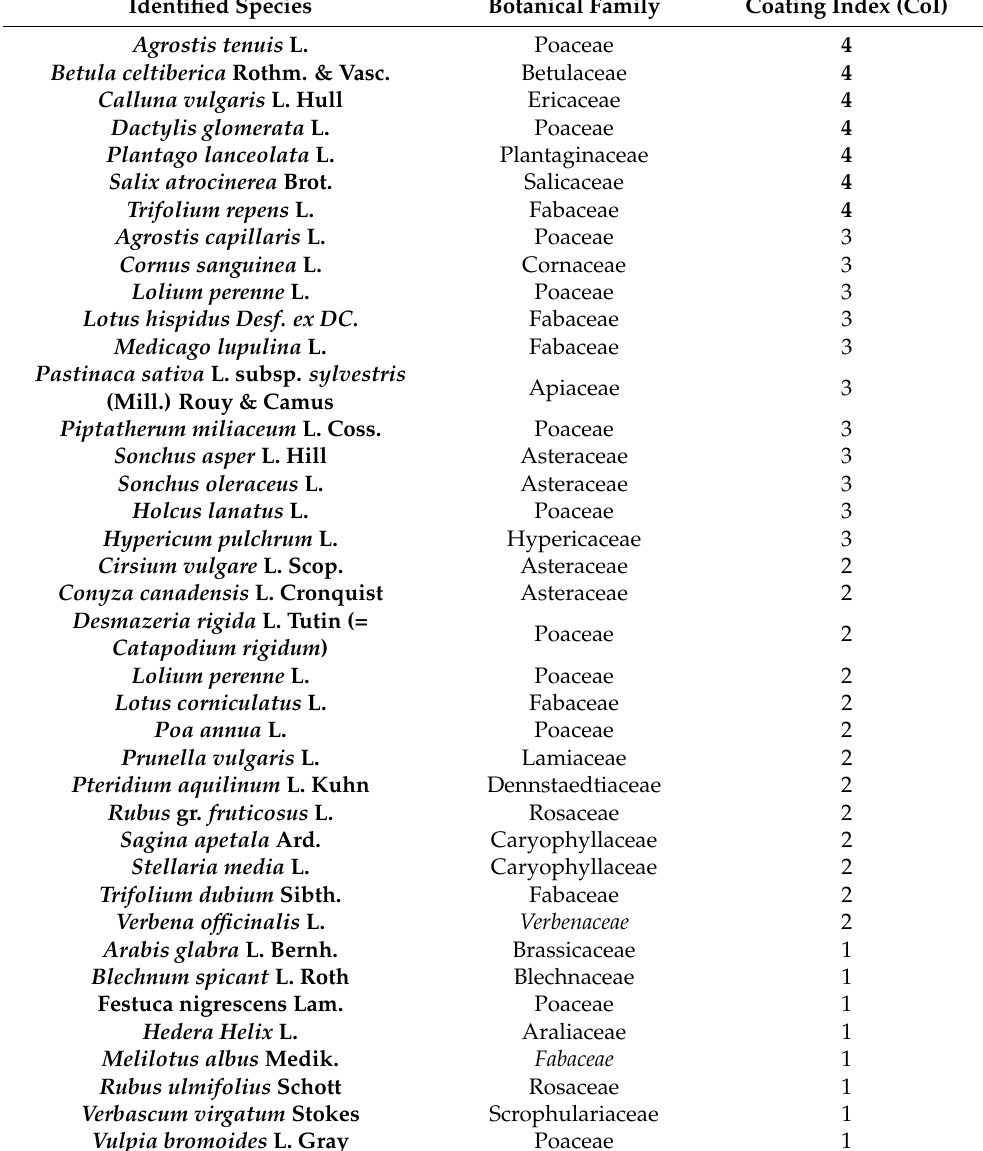
Table 2. Distribution of vegetation taking into account Coating index (abundance, coverage, density, and frequency). The botanical and ecological characteristics of the selected 7 species with CoI = 4 are described in the Supplementary Materials, Table